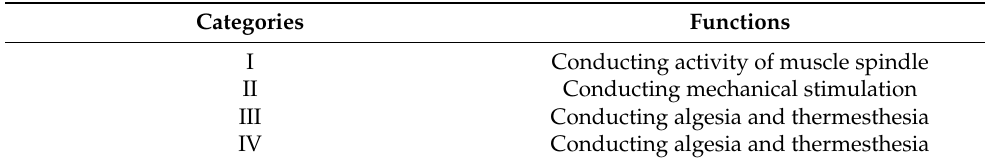
Table 2. Classification of peripheral sensory